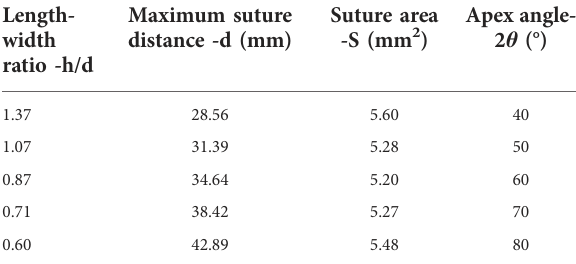
TABLE 1 Comparison of geometrical parameters of A-T fl